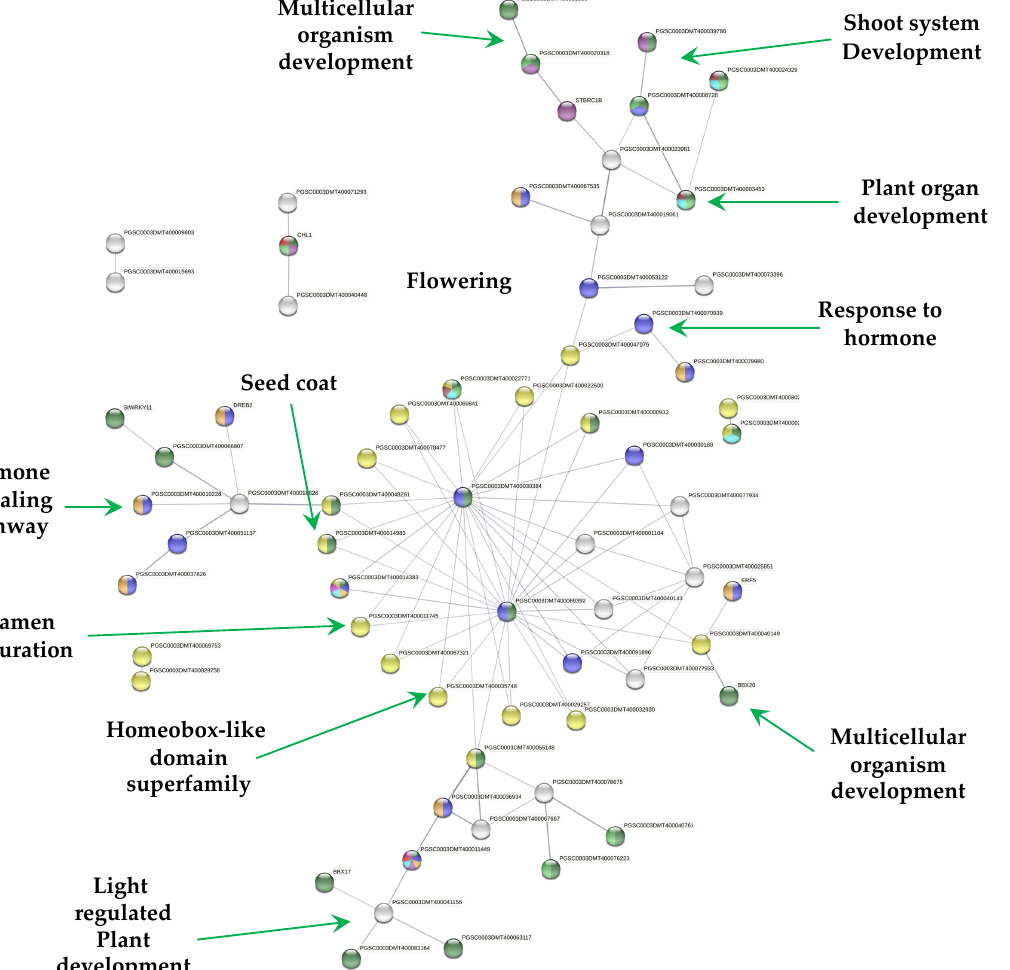
Figure 5. The PPI network of down-regulated TFs derived using the STRING database from the transcriptomic-wide analysis of potato S. tuberosum with medium confidence (0.400). The figure represents a full network, the edges indicate both functional and physical protein